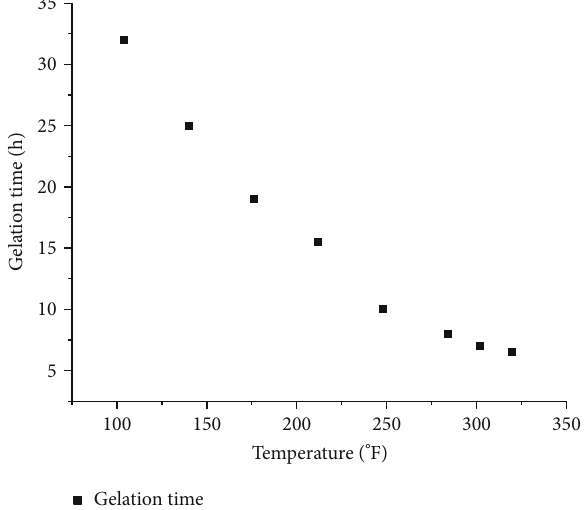
Figure 16: The e ff ect of temperature on the gel-forming e ff ect of the